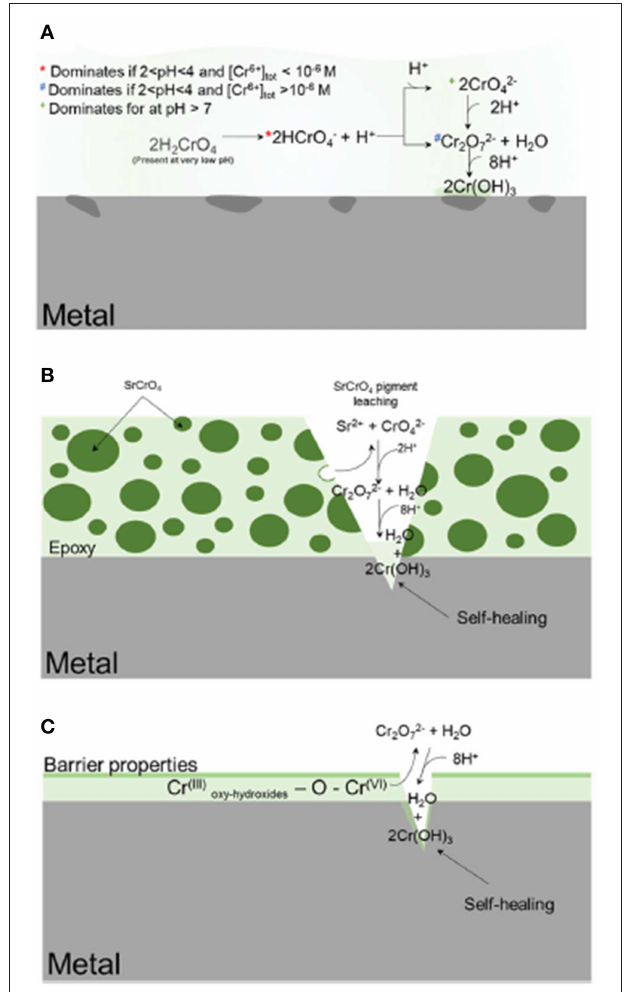
FIGURE 1 | Schematic representation of the various delivery methods for deploying chemical inhibitors to corrosion-susceptible surfaces ( Koch, 2017). In (A) , the inhibitor is globally deployed; in (B) , the inhibitor is embedded and slowly released from a metal-rich primer; in (C) , the inhibitor is incorporated into a metallic coating. The gray is the metal substrate, the dark green is the SrCrO 4 particles, and light green is the epoxy resin. The intermediate shade of green is deposited Cr-based corrosion product. Reproduced with permission.